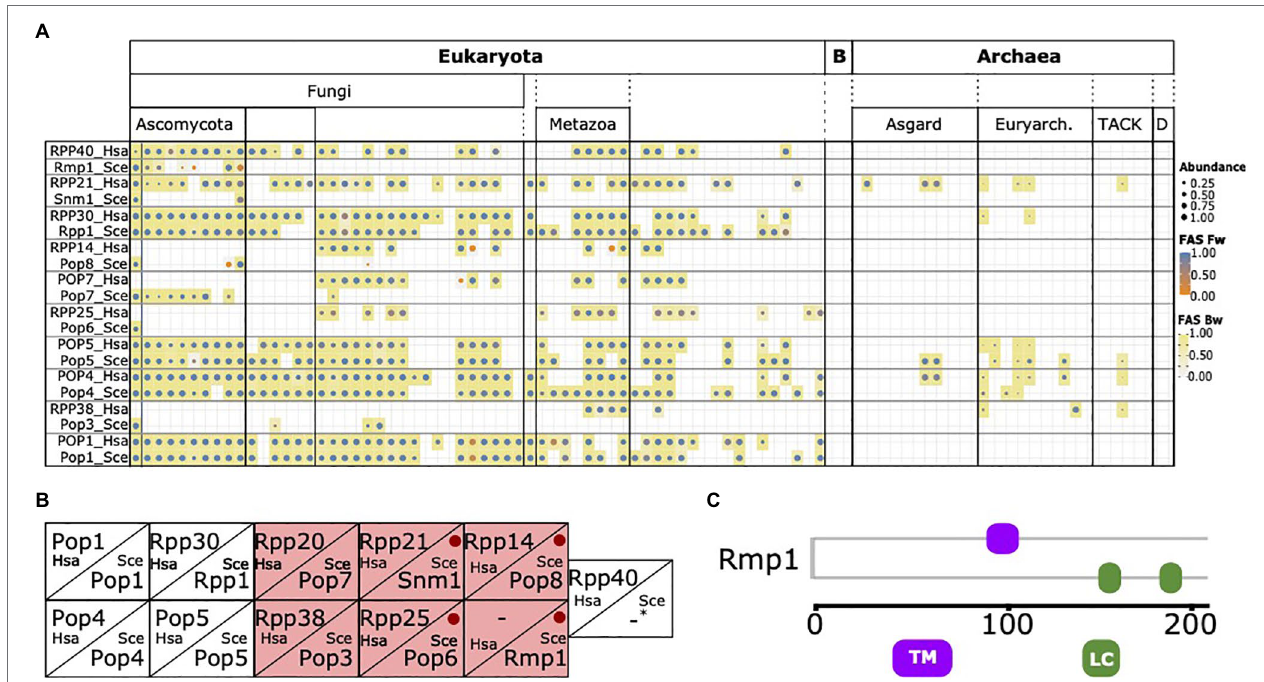
FIGURE 5 | The phylogenetic profile of the RNase MRP components. (A) The phylogenetic profiles of the 10 yeast and human RNase MRP components. Human and yeast components considered functionally equivalent are placed in one box. (B) Corresponding components of RNase MRP complex in yeast and human according to Rosenblad et al. (2006). Yeast proteins with a missed human ortholog in (A) are highlighted in red. Red dots indicate yeast proteins with a traceability index below 0.75 in humans, indicating that orthologs most likely have diverged beyond recognition (Snm1 = 0,58; Pop6 = 0,48; Pop8 = 0,58; and Rmp1 = 0). For human RPP40 and yeast Rmp1 no corresponding protein in the other species are known. (C) Domain architecture of yeast Rmp1. TM, transmembrane domain; LC, low complexity region. See Supplementary Figure S4 for the domain architectures of the remaining five